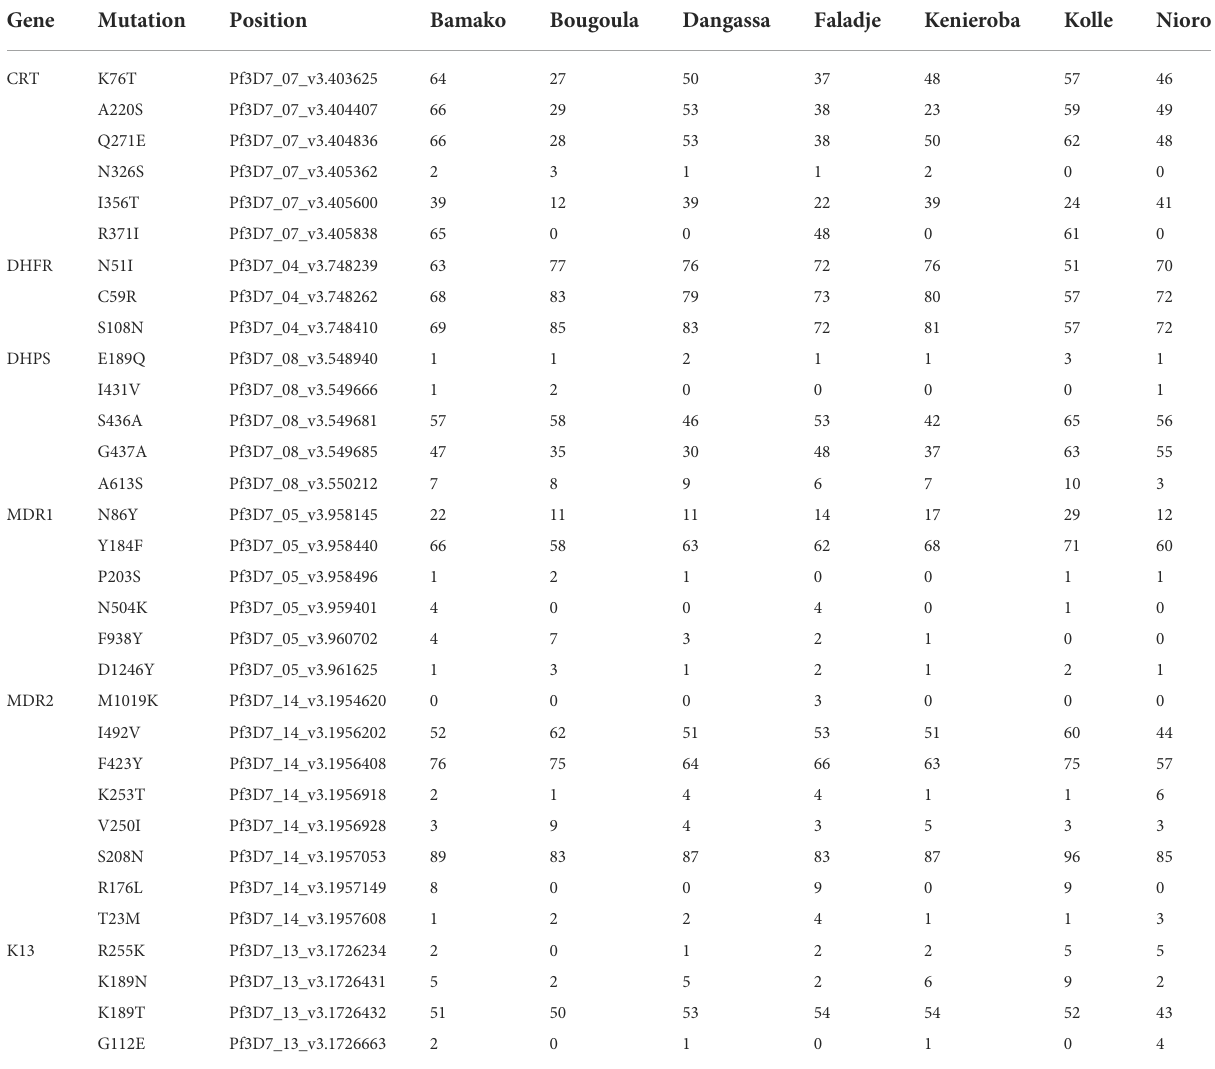
TABLE 1 Percentage of isolates in Mali with mutant variants within known Plasmodium falciparum drug-resistance-associated genes. Only variants found in at least 2 percent of any of the geo-temporal populations are presented. Gene